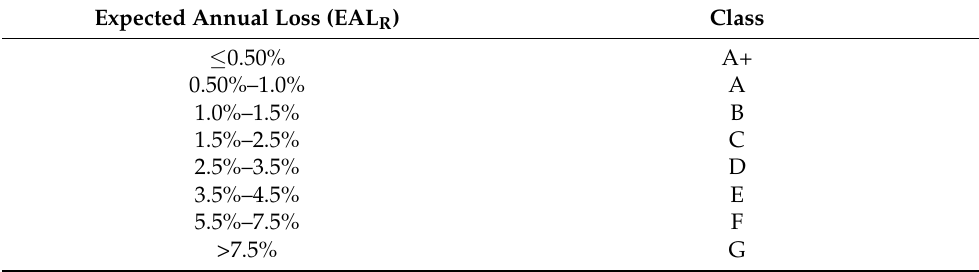
Table 13. Reference values of EAL R for seismic risk classes definition